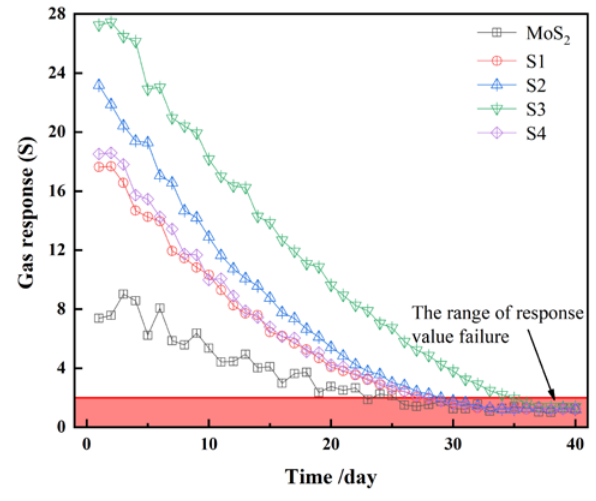
Figure 12. Gas-sensing response curve of each gas-sensing material during the 40-day aging process.